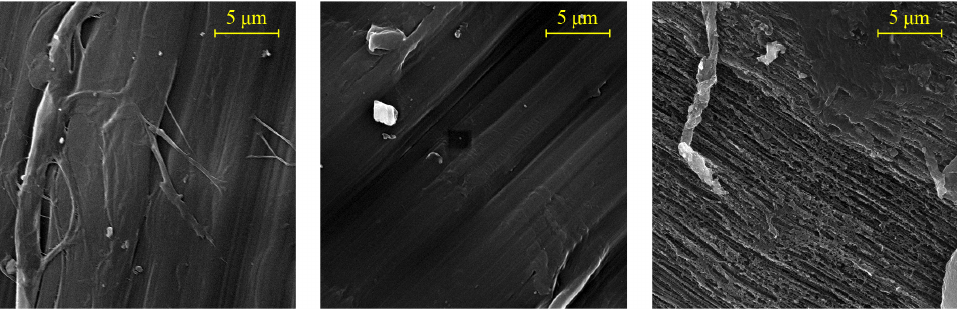
Figure 4. SEM images of reference (left), 30 s (middle) and 480 s (right) plasma treated BeneSteel